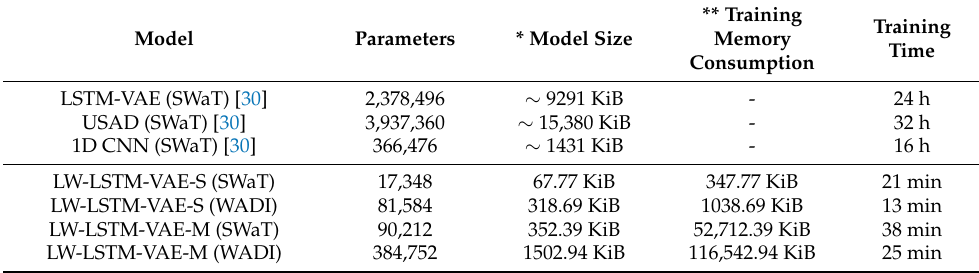
Table 8. The training efficiency of the lightweight neural network architectures presented in this work. Unfortunately, only [30] reported the specific model parameters for direct comparison with previous works. * The model size is computed based on the Float32 data type. ** The memory consumption refers to a batch size of 128 that we used for training our